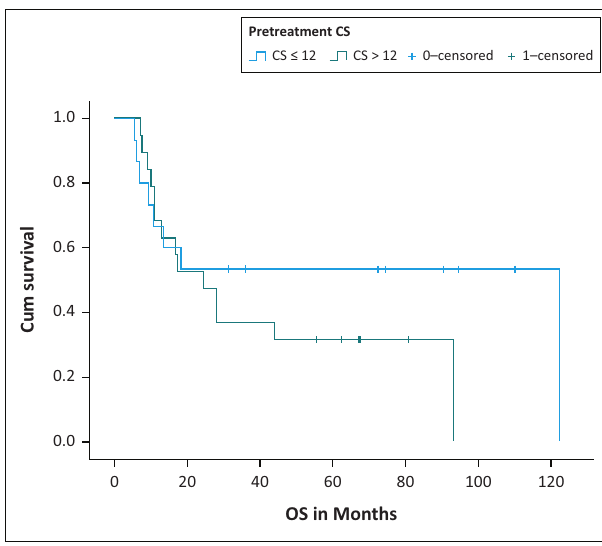
CS, Curie score; OS, overall survival. FIGURE 1: Overall survival compared with the baseline Curie score for scores ≤ 12 versus > 12.